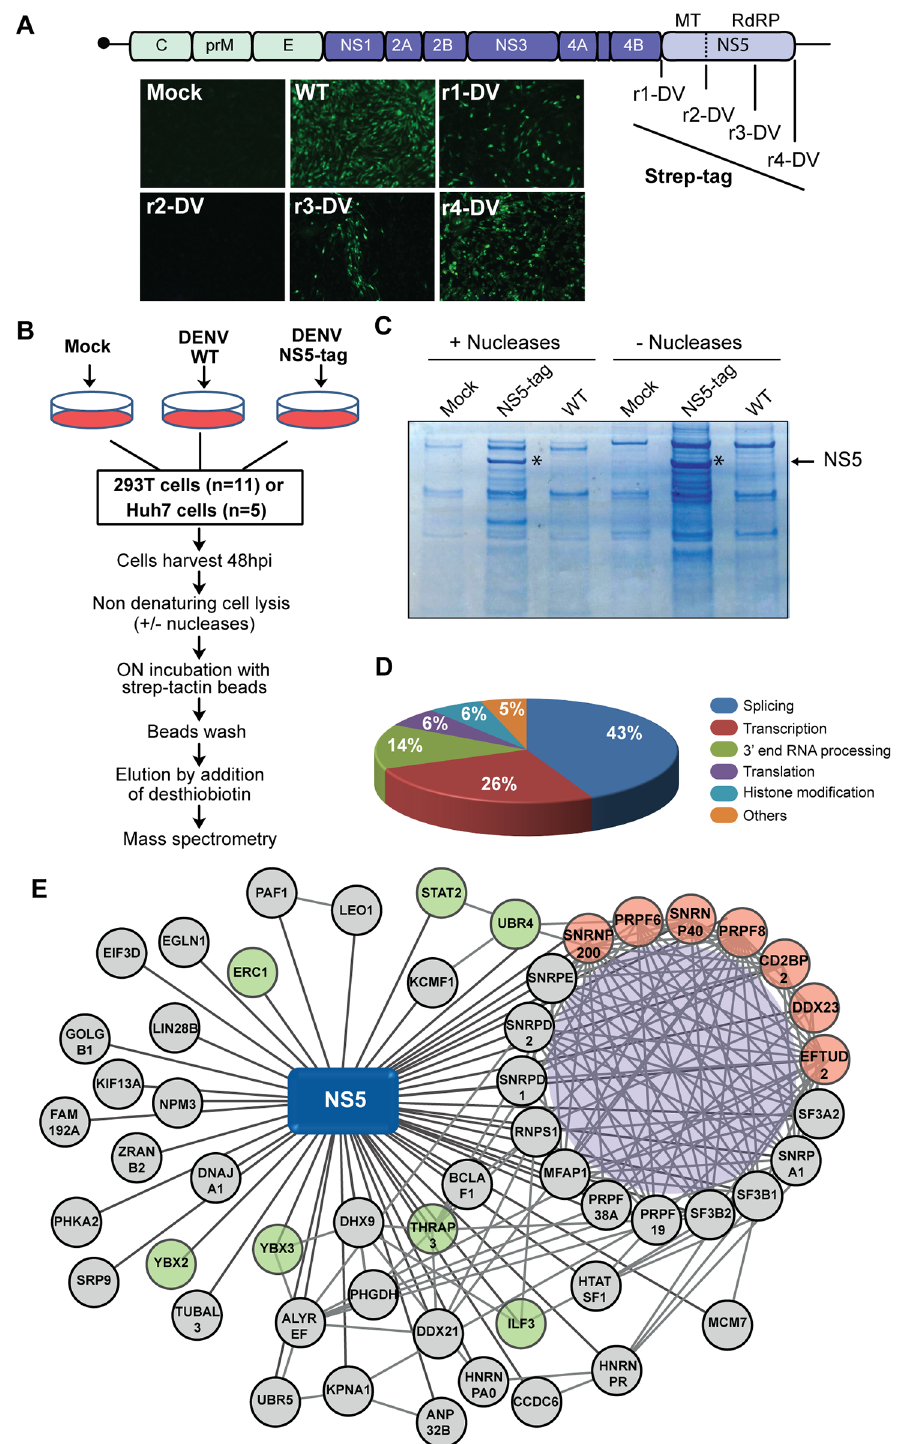
Fig 1. Interaction network of DENV NS5 and human proteins from infected cells. (A) Construction of recombinant DENVs. Viruses with Strep-tag fused to NS5 in different positions: N-terminus (r1-DV), inter-domain linker (r2-DV), low conserved loop region (r3-DV) and C-terminus (r4-DV) are shown. Immunofluorescence assays after RNA transfection using specific anti-E antibodies show replication of each virus. (B) Flow chart of experimental procedure for NS5-containing protein complex purification.